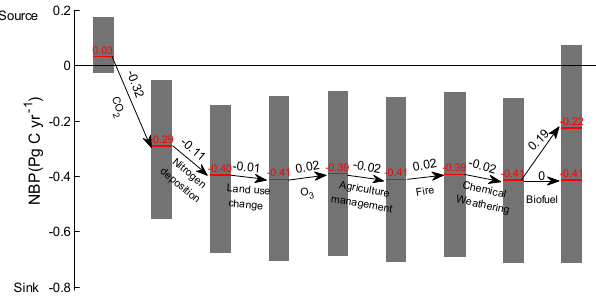
Fig. 6. Different factors’ (climate, climate+CO 2 , nitrogen depo- sition, land-use change, O 3 pollution, agricultural management, fire and biofuels) contributions to the carbon balance of terres- trial ecosystems in East Asia. Negative values indicate net carbon sink. Grey bars show ranges in the estimates by different models or sources. Biofuel emissions are fully accounted for when assum- ing the harvested carbon stock is not compensated by vegetation re- growth, and they are not accounted for when assuming the harvested carbon stock is fully compensated by vegetation regrowth. Potential interactions among different factors are not considered. The contri- butions of atmospheric O 3 pollution and agriculture management on the carbon balance are estimated over China rather than over the entire East Asia region due to lack of information for other countries (see Sect.